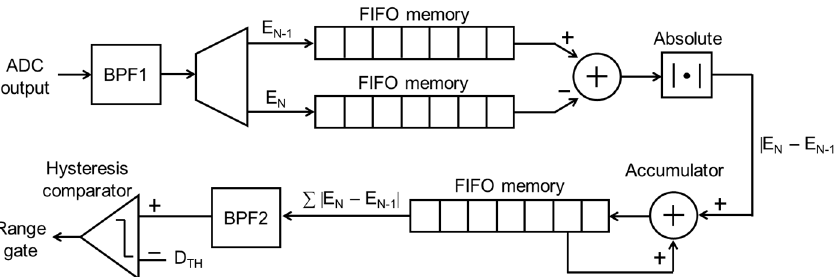
Figure 7. Block diagram of range-gate-positioning scheme in FPGA; ADC: analog-to-digital converter;